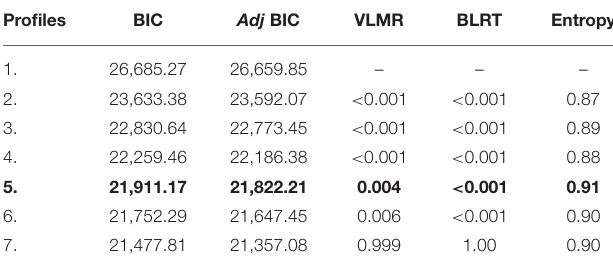
TABLE 2 | Model fit indices for 1- through 7-profile